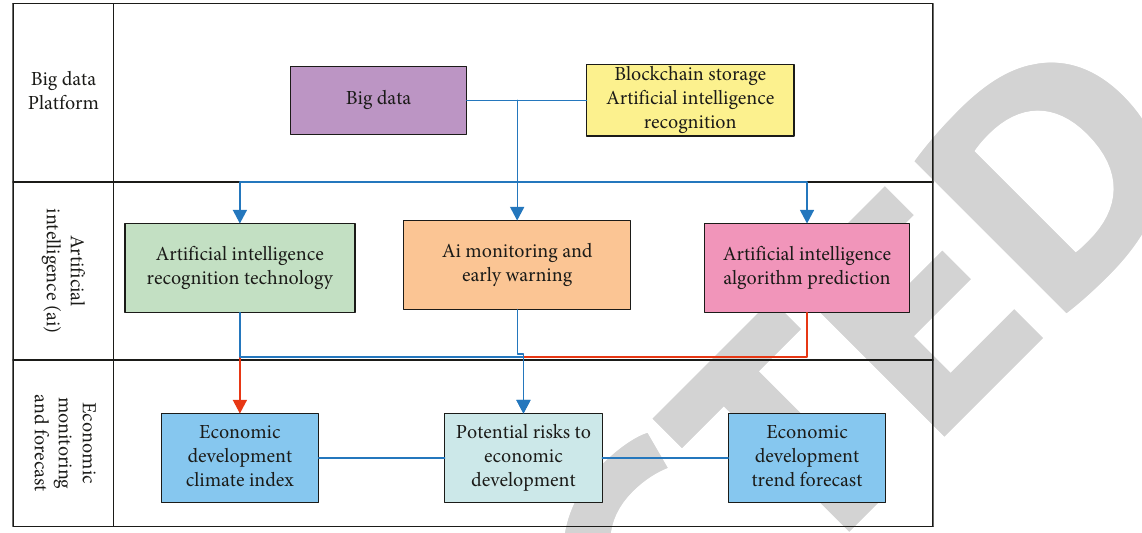
Figure 5: Construction of monitoring and early warning